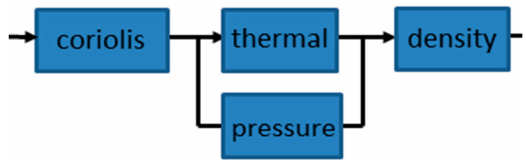
Figure 3. Schematic of the measurement setup.